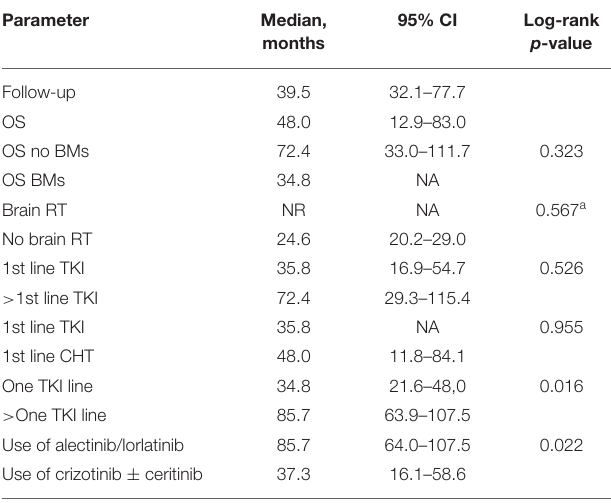
TABLE 2 | Patients’ outcome ( n =